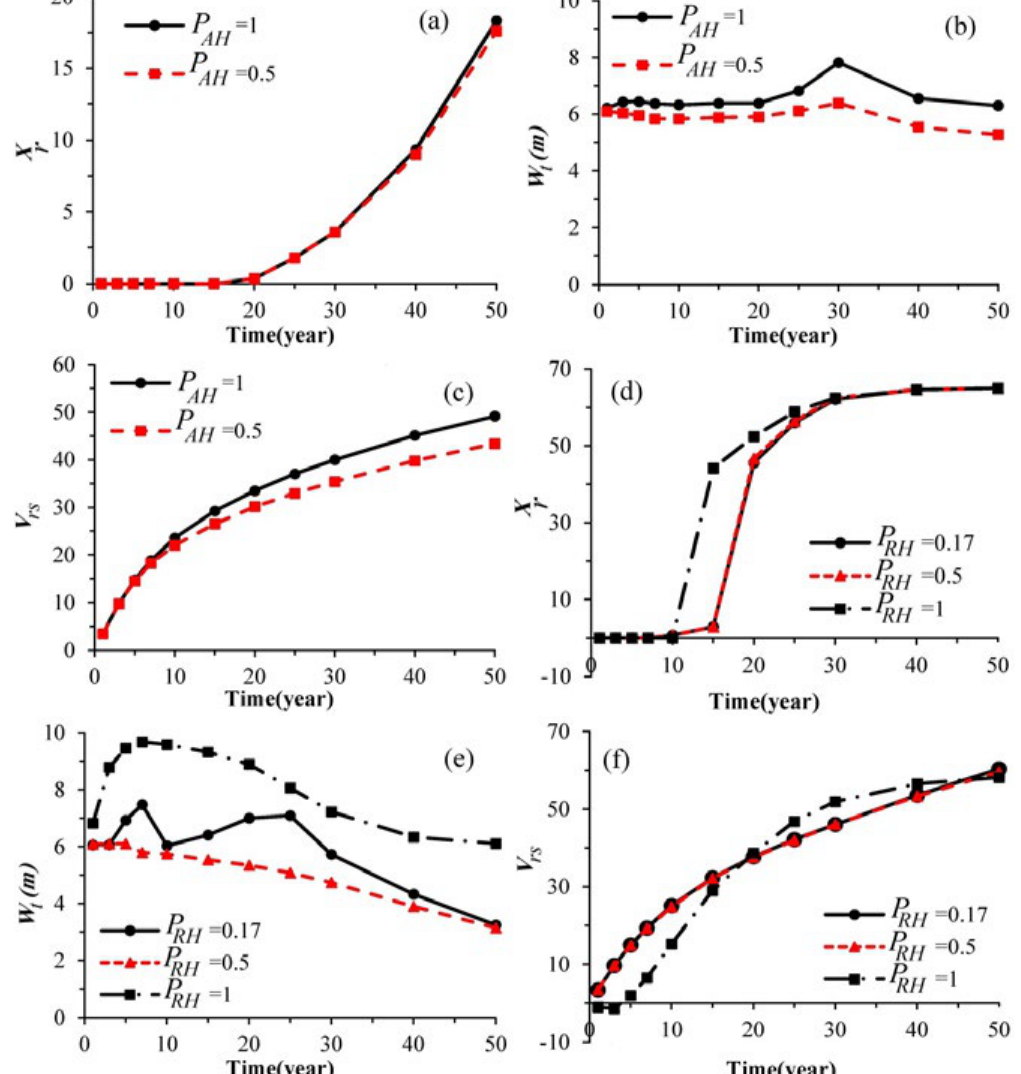
Fig. 4. The ADR efficiency (a), (b), (c) for different depth of abstraction well and (d), (e) and (f) for different depth of recharge well